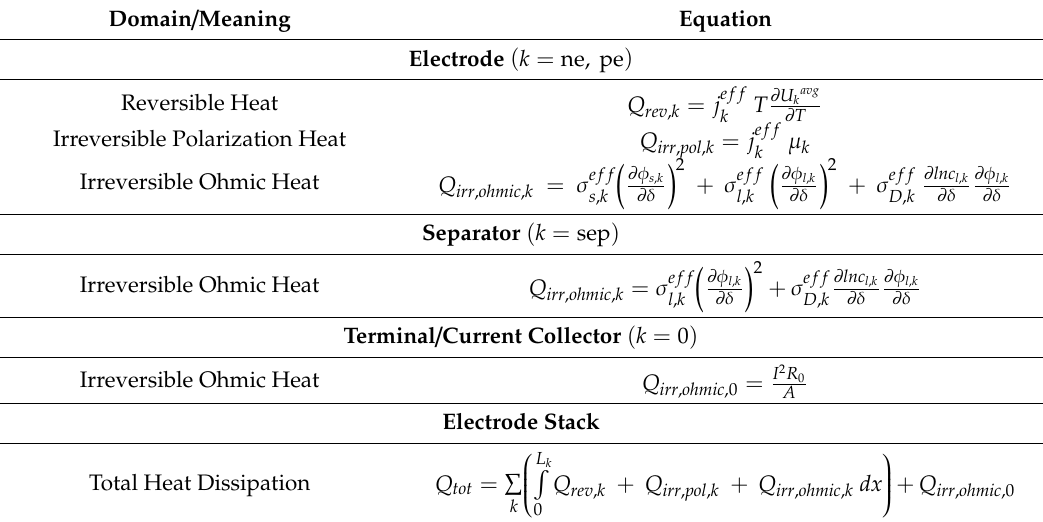
Table A2. The heat dissipation sources within the physicochemical